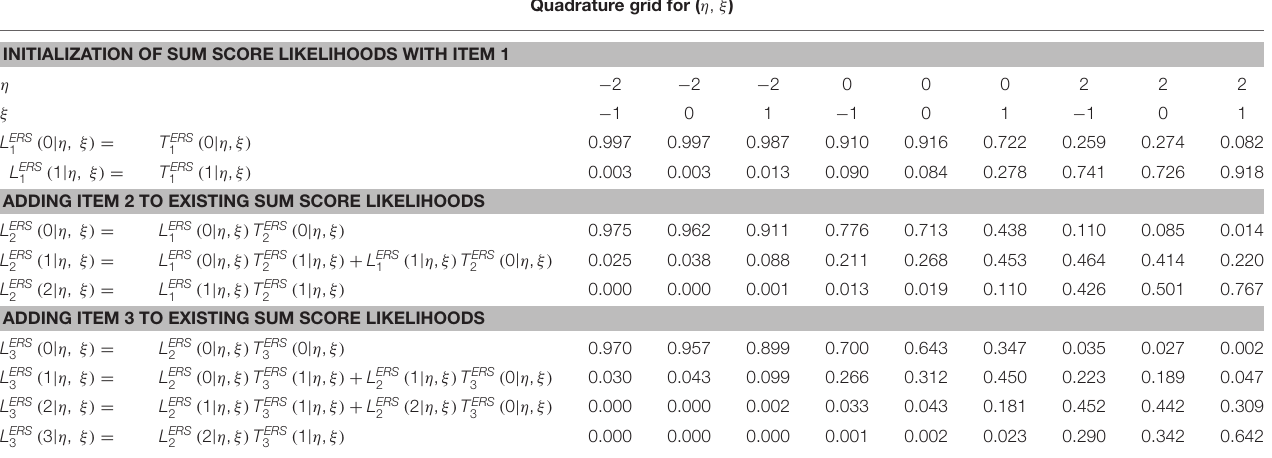
TABLE 8 | Adding weights and integrating over the nuisance dimension.